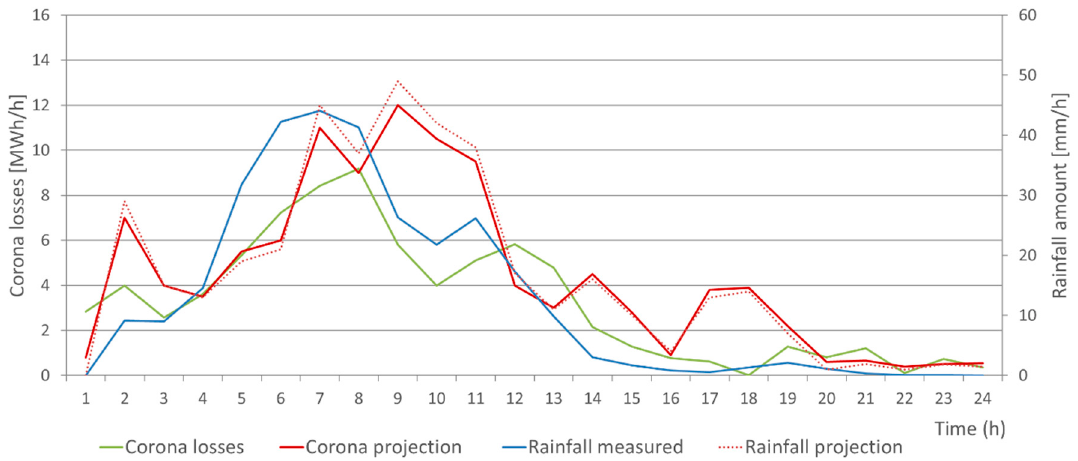
Figure 20. Comparison of the corona prediction values and measured corona values for the observed 400 kV OHL on 20